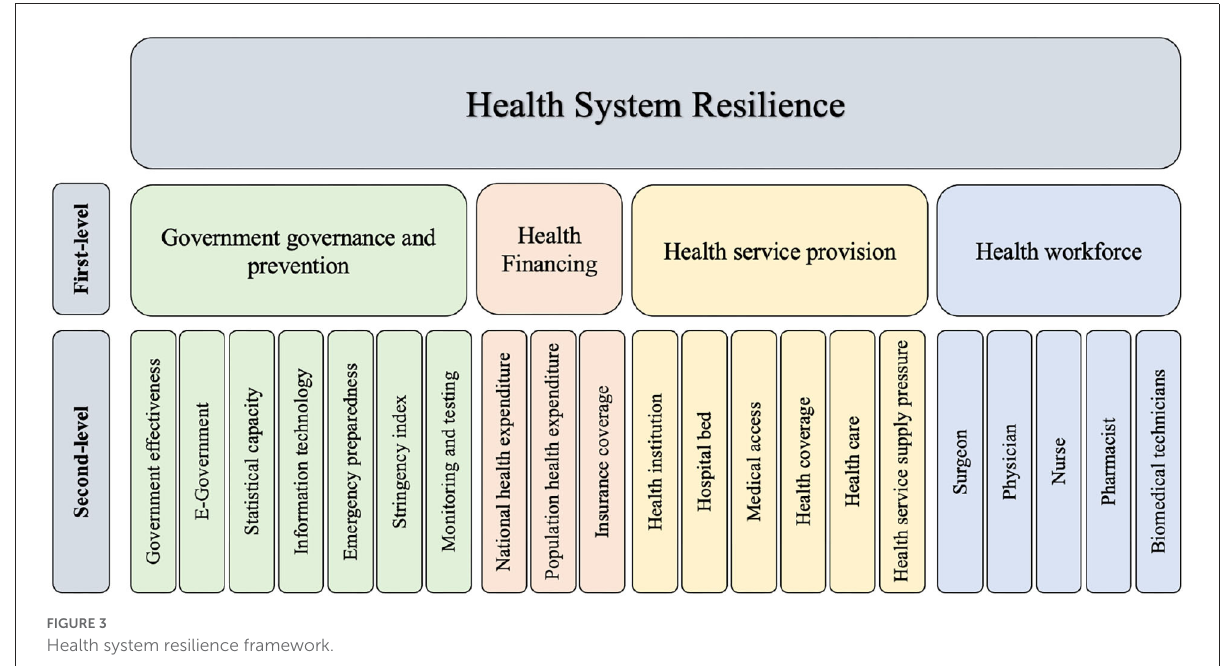
FIGURE3 Health system resilience